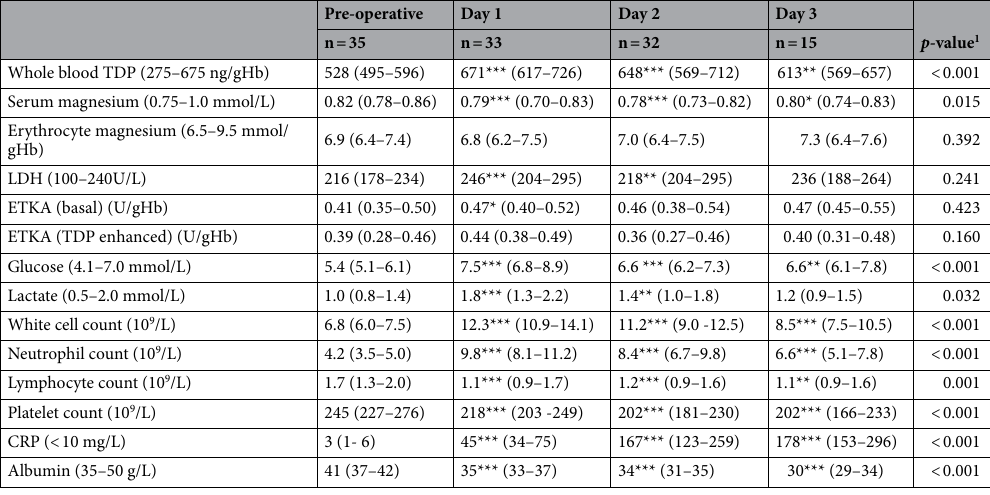
Table 2. Pre and post-operative measurements of thiamine and magnesium, dependent enzyme activity and intermediary metabolism in patients undergoing elective knee arthroplasty surgery (n = 35). Values are medians; IQR in parentheses. TDP thiamine diphosphate, CRP C-reactive protein, LDH lactate dehydrogenase, ETKA erythrocyte transketolase activity, Significant difference from pre-operative values calculated by Wilcoxon’s signed-rank test: *p ≤ 0.05, **p < 0.01, ***p < 0.001. 1 Friedman’s